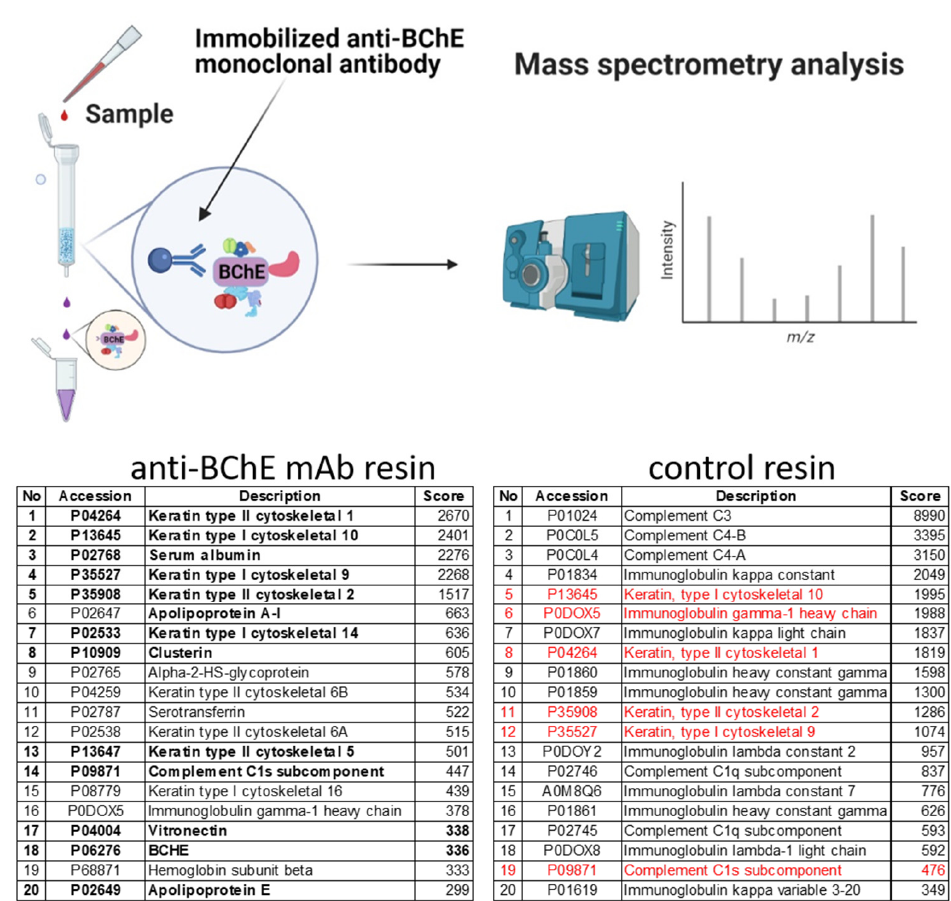
Figure 4. Scheme of the isolation of protein complexes by co-immunoprecipitation, which is a common approach to study protein–protein interactions that uses an antibody to immunoprecipitate the antigen (bait protein) and co-immunoprecipitate any interacting proteins (prey proteins). Isolation of native protein complexes from fraction 12 was performed using immobilized monoclonal antibodies on agarose support according to the instruction of the Thermo Scientific Pierce Co-Immunoprecipitation (Co-IP) Kit (Thermo Fisher Scientific, Waltham, MA, USA). The proteins in complexes were eluted and identified by mass spectrometry. The table lists the first 20 most abundant proteins identified in complexes, sorted according to the score number from the Mascot server. The score in the table is a qualitative measure, not quantitative. The higher the score, the more reliable the identification. The proteins that have also been pulled down using Hupresin AC Sepharose are listed in the table in Figure 2 in bold text. The control resin table lists proteins nonspecifically interacting with the control quenched antibody coupling resin. The proteins identified in both tables (with anti-BChE antibody and in control) are marked in red. Keratin and the immune system proteins seem to bind nonspecifically to the resins in the above pull-down experiments. Figures 4 was created with BioRender.com (access on March 15, 2021).